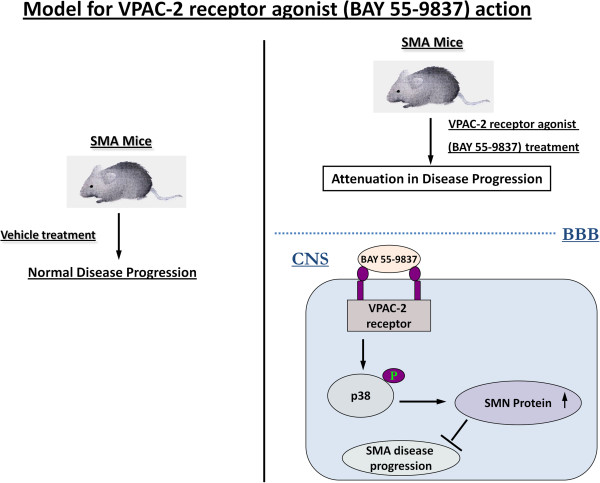
Model for VPAC2 receptor agonist (BAY 55-9837) action.